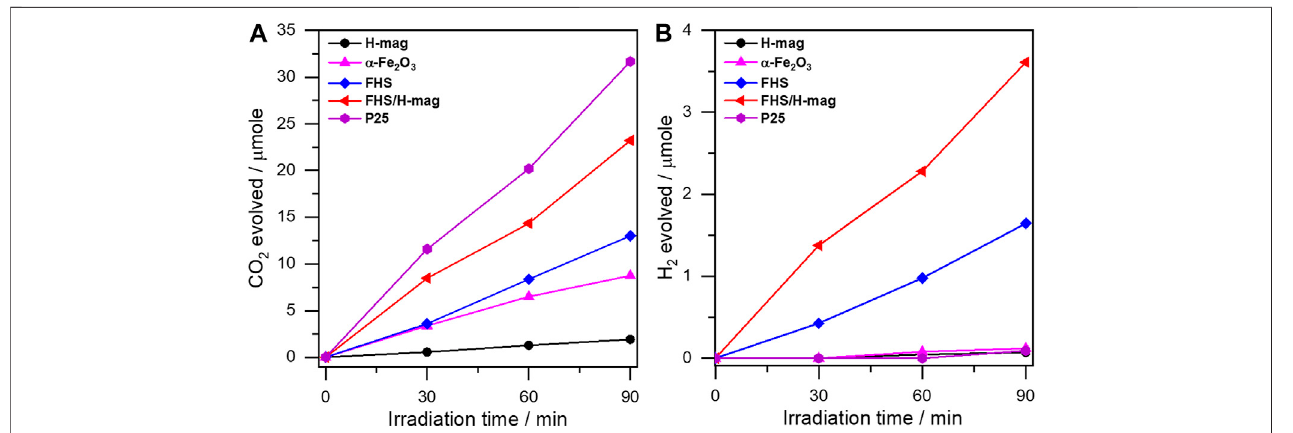
FIGURE 5 | (A) CO 2 evolution and (B) H 2 evolution pro fi les on different materials from an aerated aqueous solution containing FA under solar simulator irradiation.